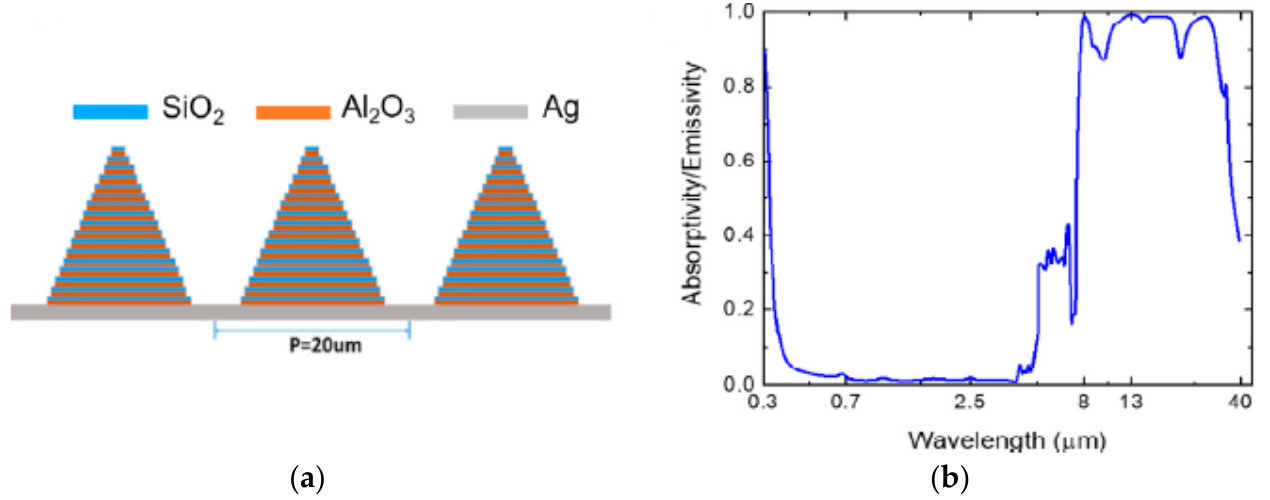
Figure 20. ( a ) Radiative cooling using a micro pyramid structure with multiple layers of all-dielectric material. ( b ) The all-dielectric multilayer micro pyramid structure’s absorption/emissivity [122].